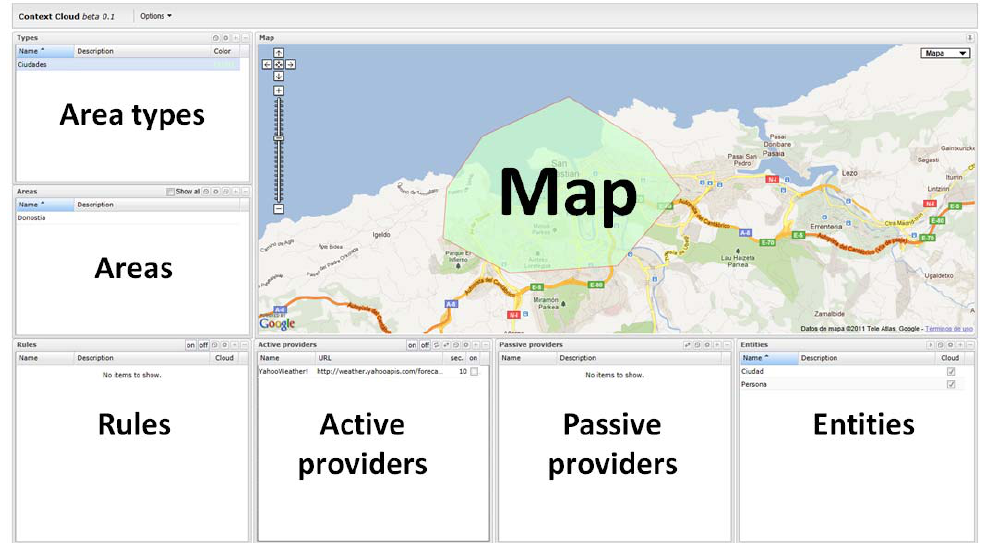
Figure 5. Configuration